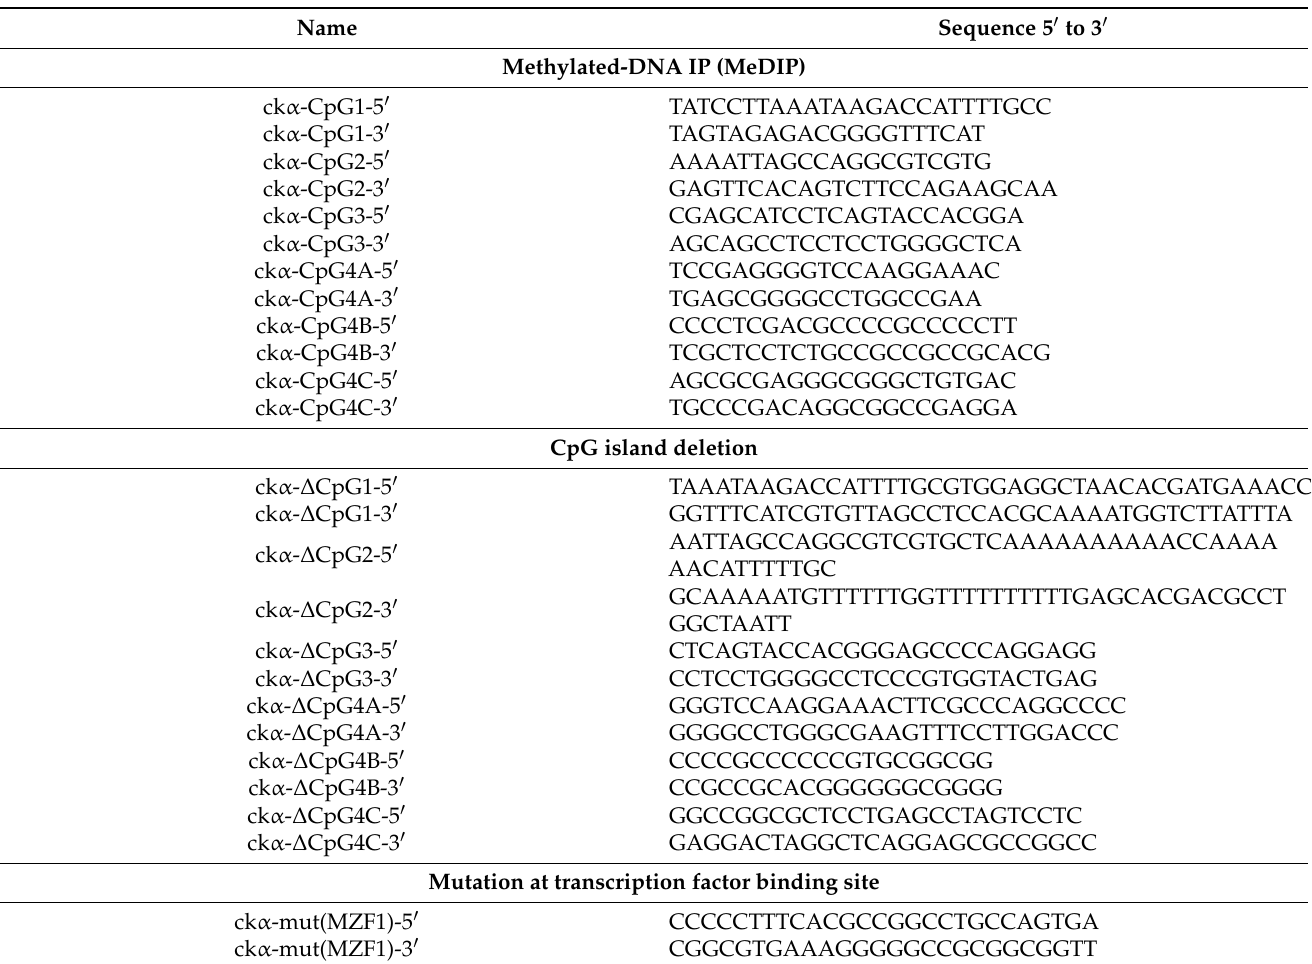
Table 1. Primers used for methylated-DNA immunoprecipitation and PCR-based site-directed